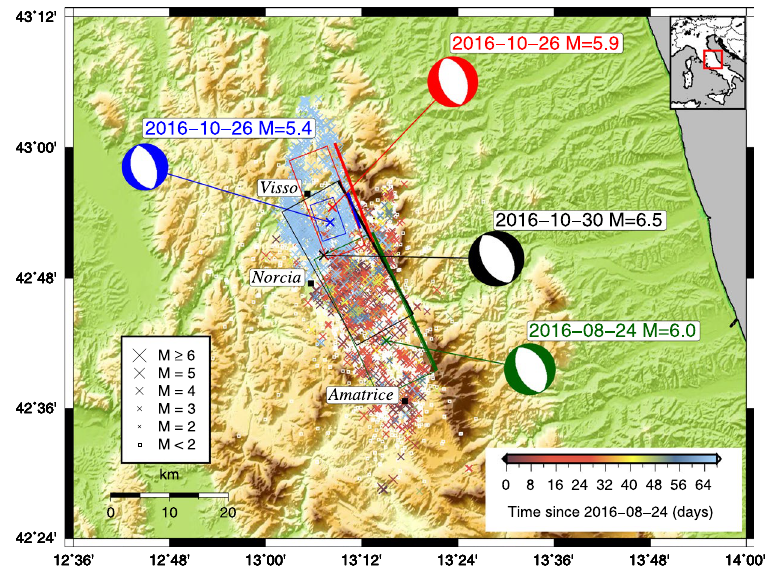
Figure 1. Seismicity map of the Amatrice seismic sequence. Epicentral location of the earthquakes occurring since 24 August 2016 to the time of the 30 October 2016, Norcia earthquake 29 . The symbol colour and size change according to time of occurrence and magnitude (except for the M < 2 events, all displayed in white colour, and for the mainshocks to preserve clarity), respectively, while the analysed events are indicated by green, blue, red, and black crosses. The fault mechanisms 14 (Supplementary Table 1) of the largest events are also displayed as beachballs, using the same colour as the location. The black rectangles represent the surface projection of the fault planes (P1 in Supplementary Table 1), as inferred from both the focal mechanisms and surface displacements 29,30 . For each plane, the intersection with the free surface is depicted by a thick line of the same